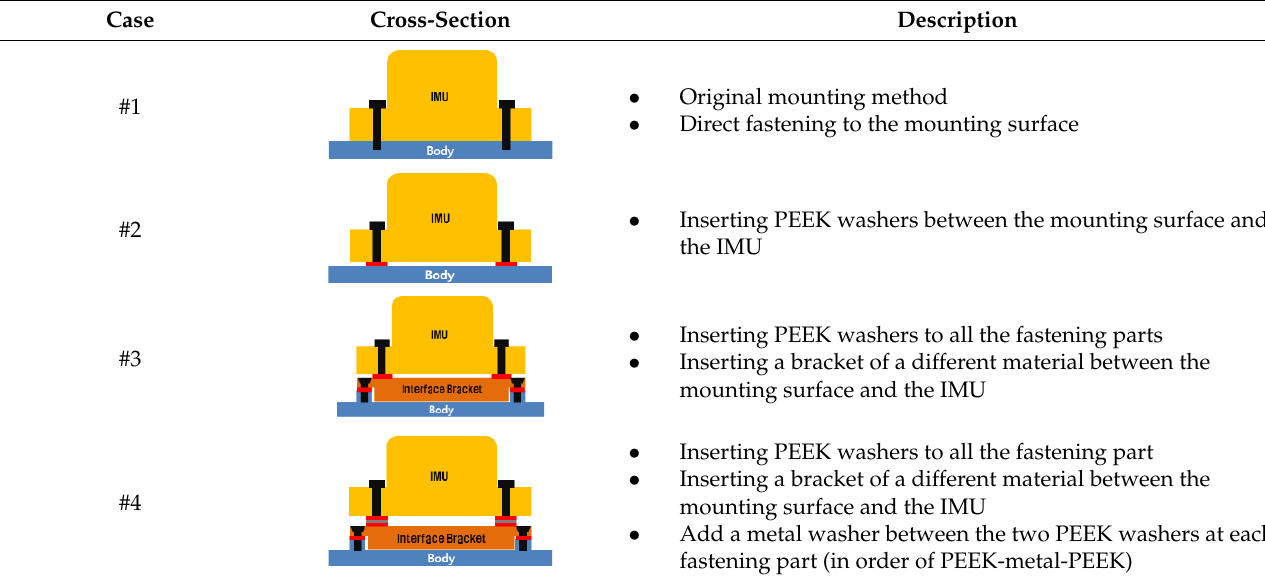
Table 1. Four methods applied for reducing pyro-shock.